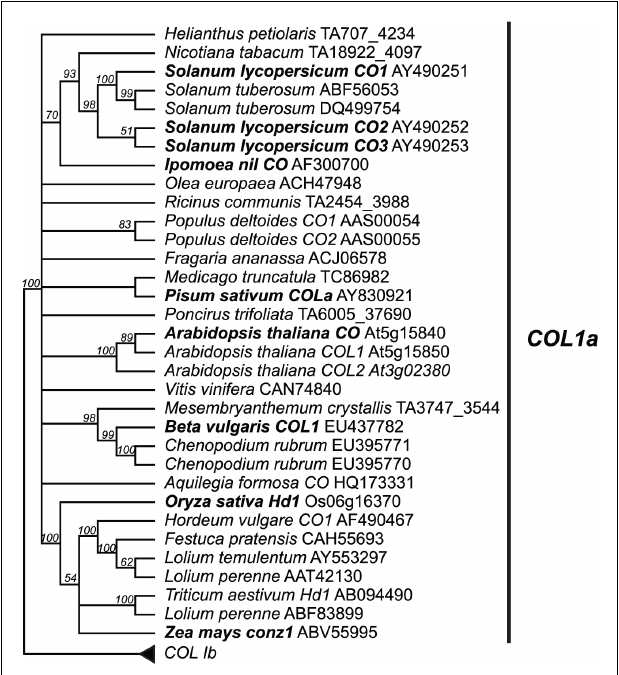
FIGURE 4 |Type Ia CO -like gene tree. The optimal maximum likelihood tree and bootstrap percentages (shown above branches) were inferred from analyses of full-length amino acid sequences using RAxML 7.0.4 (Stamatakis, 2006) with the JTT amino acid substitution matrix. All nodes with less than 50% bootstrap support have been collapsed.The type Ia clade of CO-like genes shown here has been rooted with the type Ib clade (see FigureA2 in Appendix for complete phylogeny). Genes in bold text are specifically discussed in the text. GenBank or EMBL accession numbers are provided for each